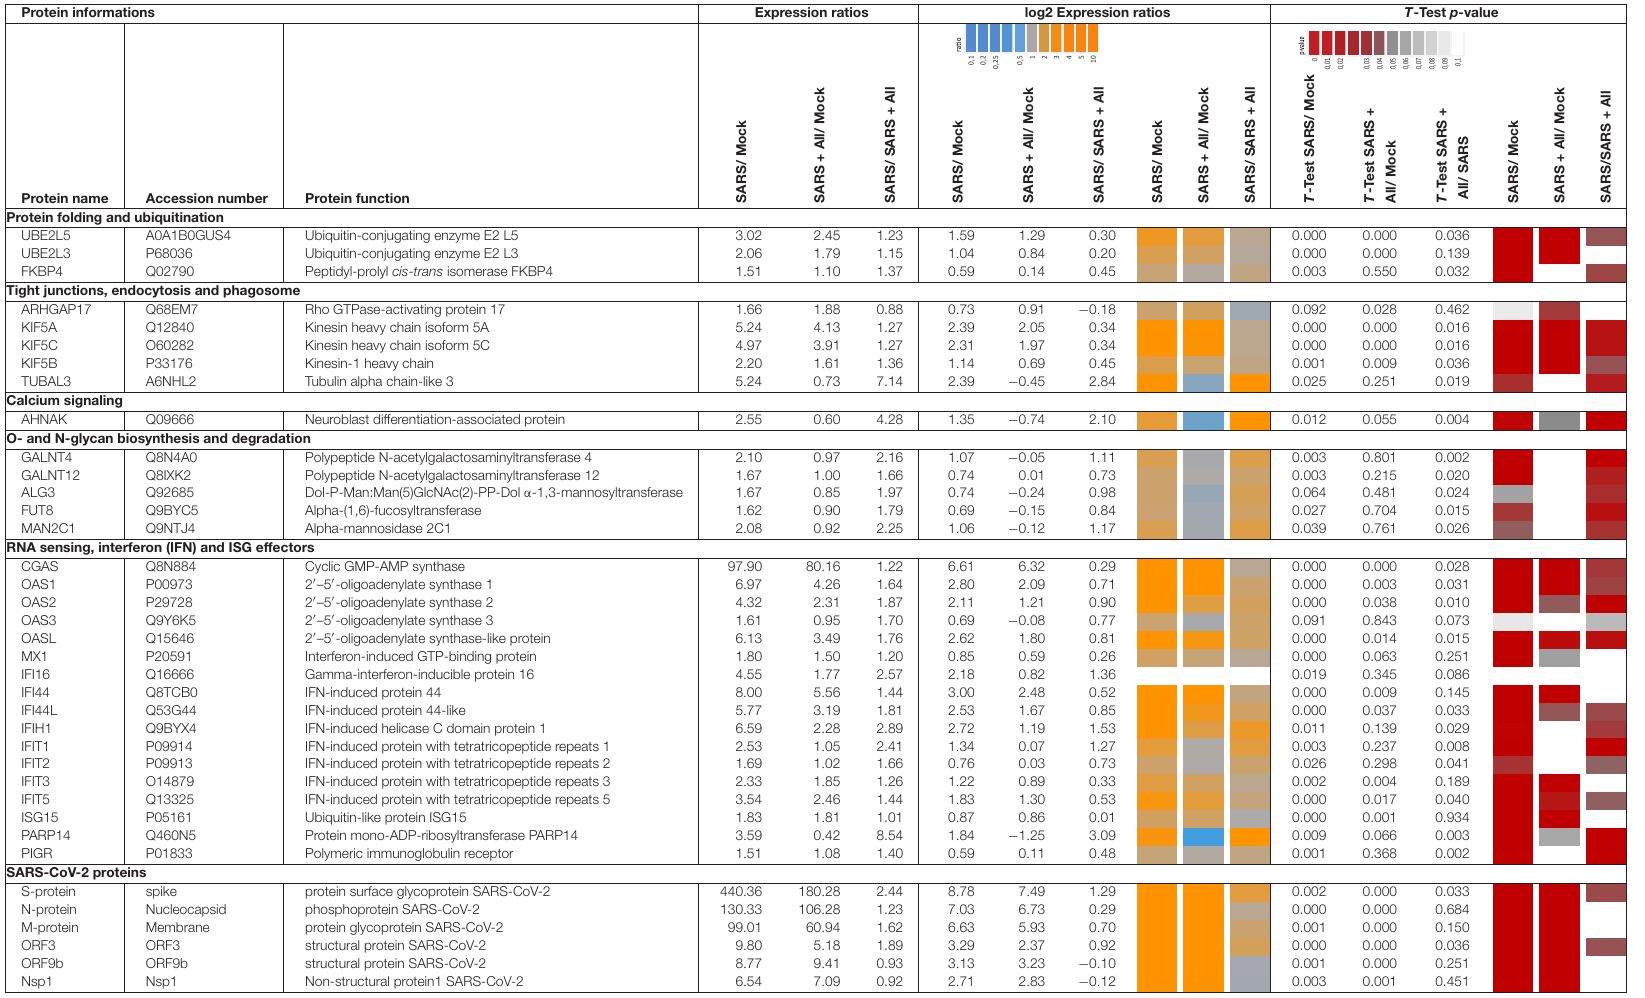
TABLE 1 | Selected most strongly induced proteins in the Calu-3 proteome after SARS-CoV-2 infection and the effect of allicin treatment p.i. Protein informations Expression ratios log2 Expression ratios